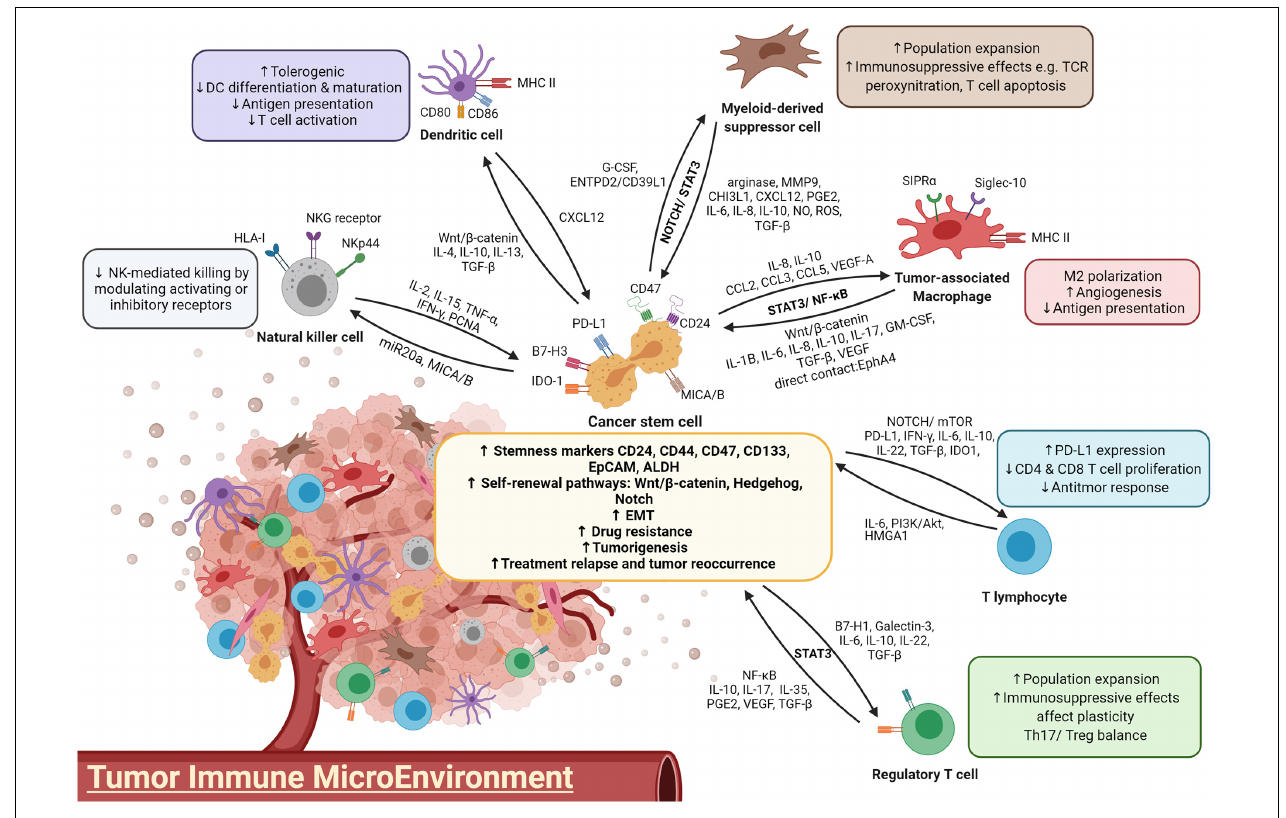
FIGURE 1 | A diagram illustrating the crosstalk between immune cells and